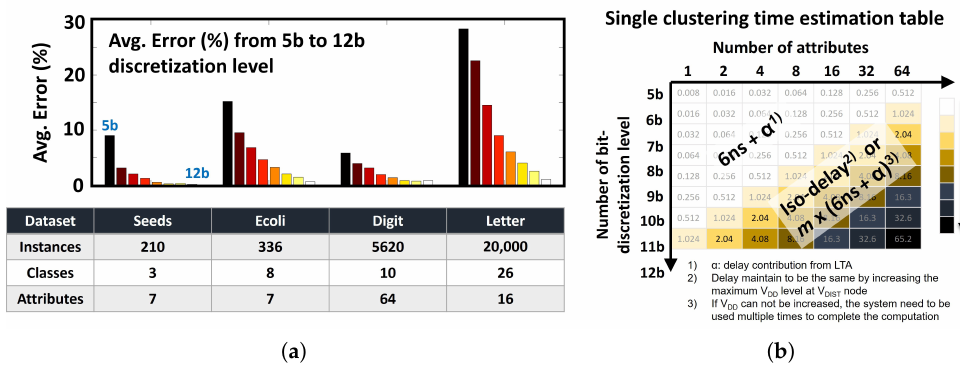
Figure 13. ( a ) Clustering accuracy for different datasets; ( b ) clustering execution time of the proposed approximate K-means clustering